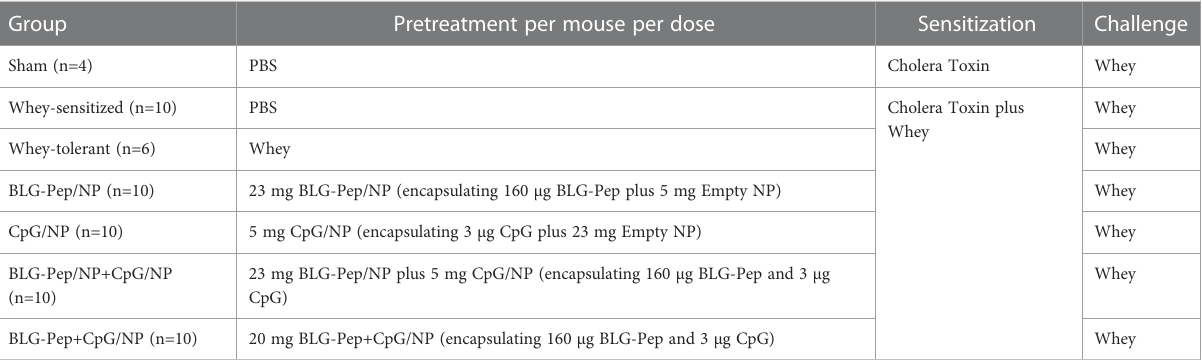
Eighteen hours after oral challenge of the mice with whole whey protein, isolation of cells from spleen (11) and mesenteric lymph nodes (MLN) (38) was performed as previously reported.